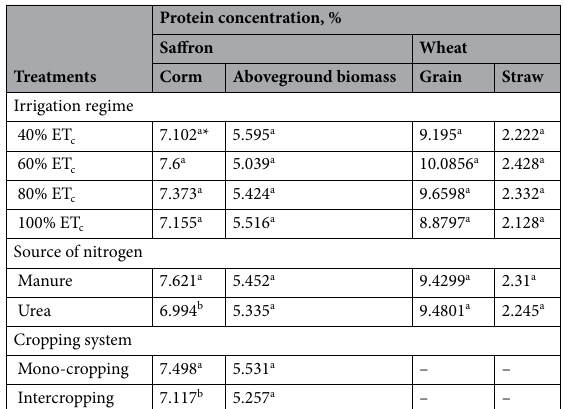
Table 7. Means for protein concentration (PC) of saffron corm, saffron plant aboveground biomass portion, winter wheat grain and straw in the last (fourth) growing season. *Means followed by similar letters in each column for each factor and each trait are not significantly different at 5% level of probability according to Tukey test.